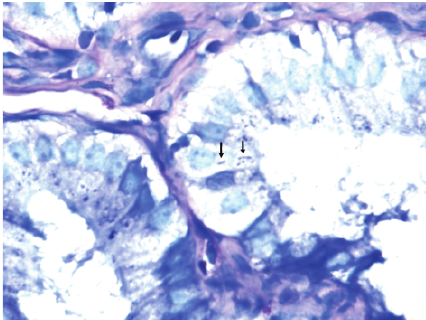
Figure 2: Immunopositivity for H. pylori along with the gallbladder mucosal columnar epithelium. Note that the bacilli are noninvasive and placed on the apical surface of the epithelium ( × 400).